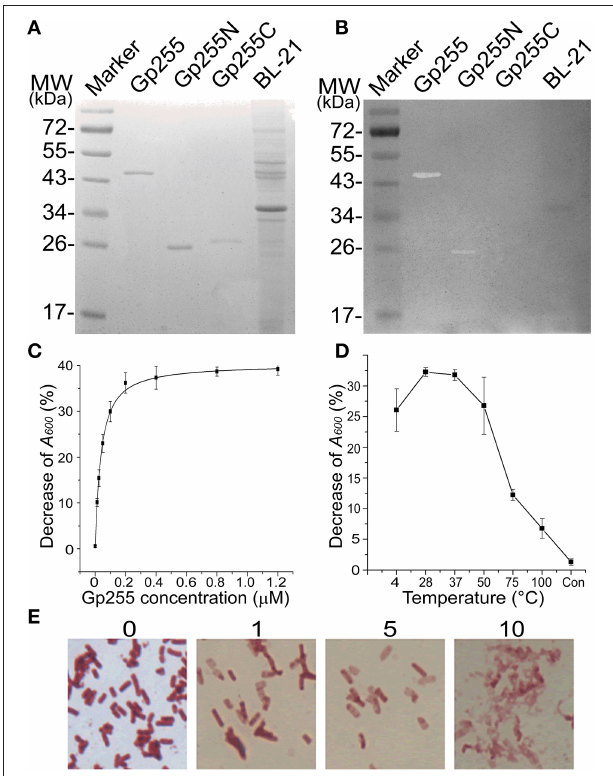
FIGURE 3 | Characterization of protein Gp255. (A) SDS-PAGE analysis of purified Gp255, Gp255N, Gp255C, and E. coli strain BL-21. (B) In-gel lytic activities of proteins Gp255, Gp255N, Gp255C, and E. coli strain BL-21. The purified proteins were mixed with loading buffer for use. (C) The influence